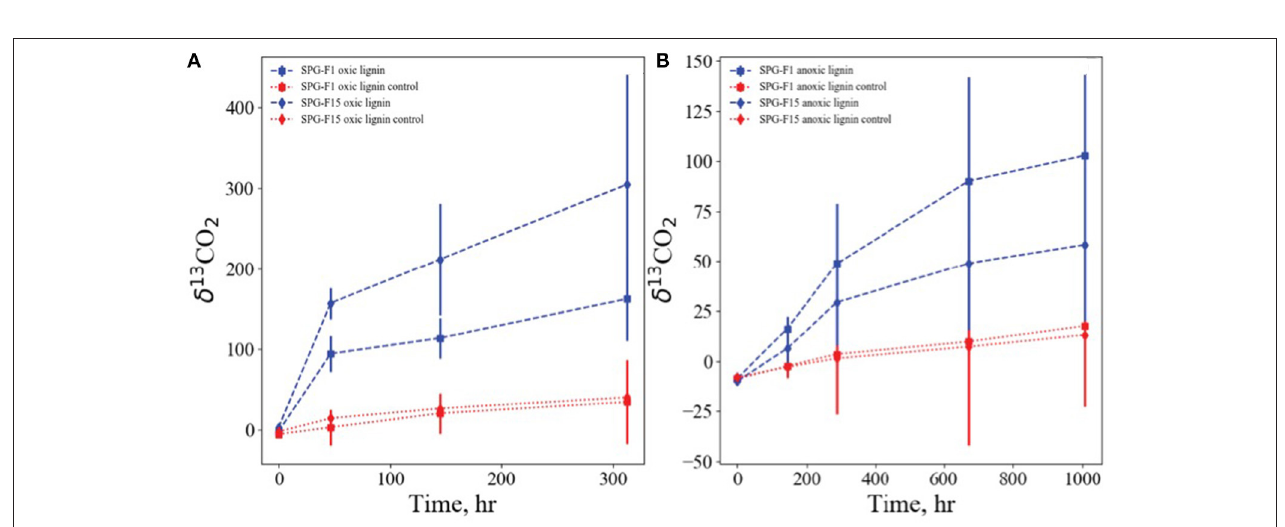
FIGURE 8 | Growth of SPG-F1 and SPG-F15 on isotopically labeled lignin under oxic (A) and anoxic (B) conditions. Shown are accumulations of lignin derived 13 C, expressed as δ 13 C-CO 2 vs. the Vienna PDB standard, in the pool of inorganic carbon over time.